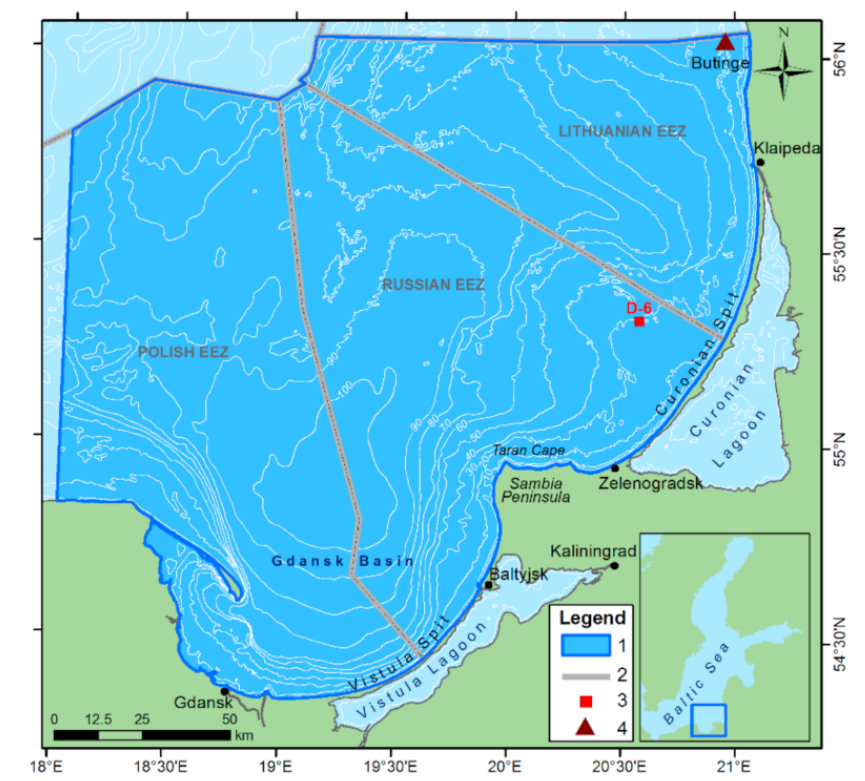
Figure 2. Study area with bottom topography (white lines). Legend: 1 = area of satellite monitoring; 2 = boundaries of the Exclusive Economic Zones (EEZs); 3 = D-6 oil platform; 4 = Butinge oil